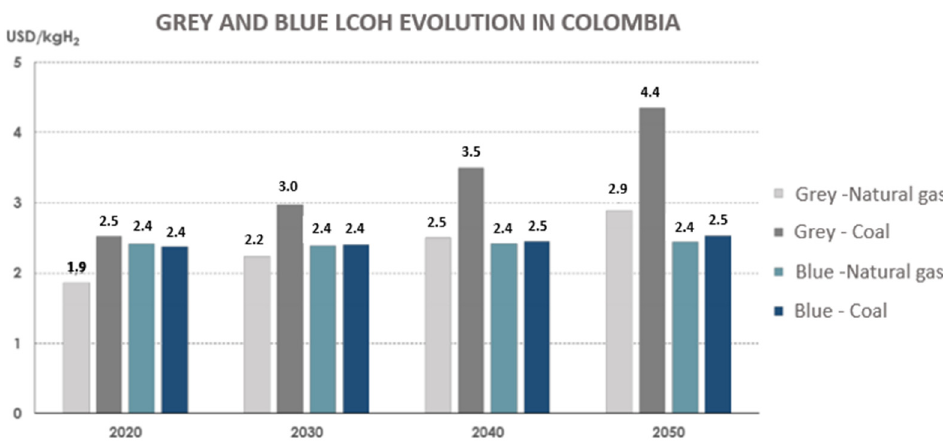
Figure 10. LCOH of coal and natural gas for blue and grey H 2 production [3].